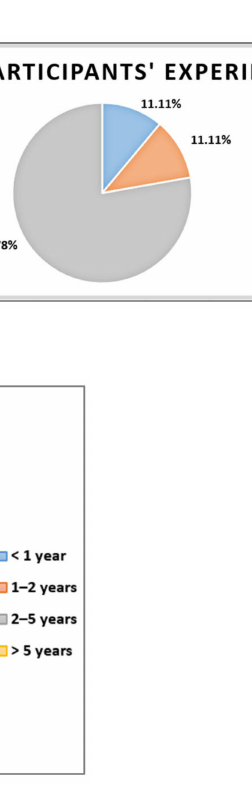
Figure A2. Information about the companies’ experiences with